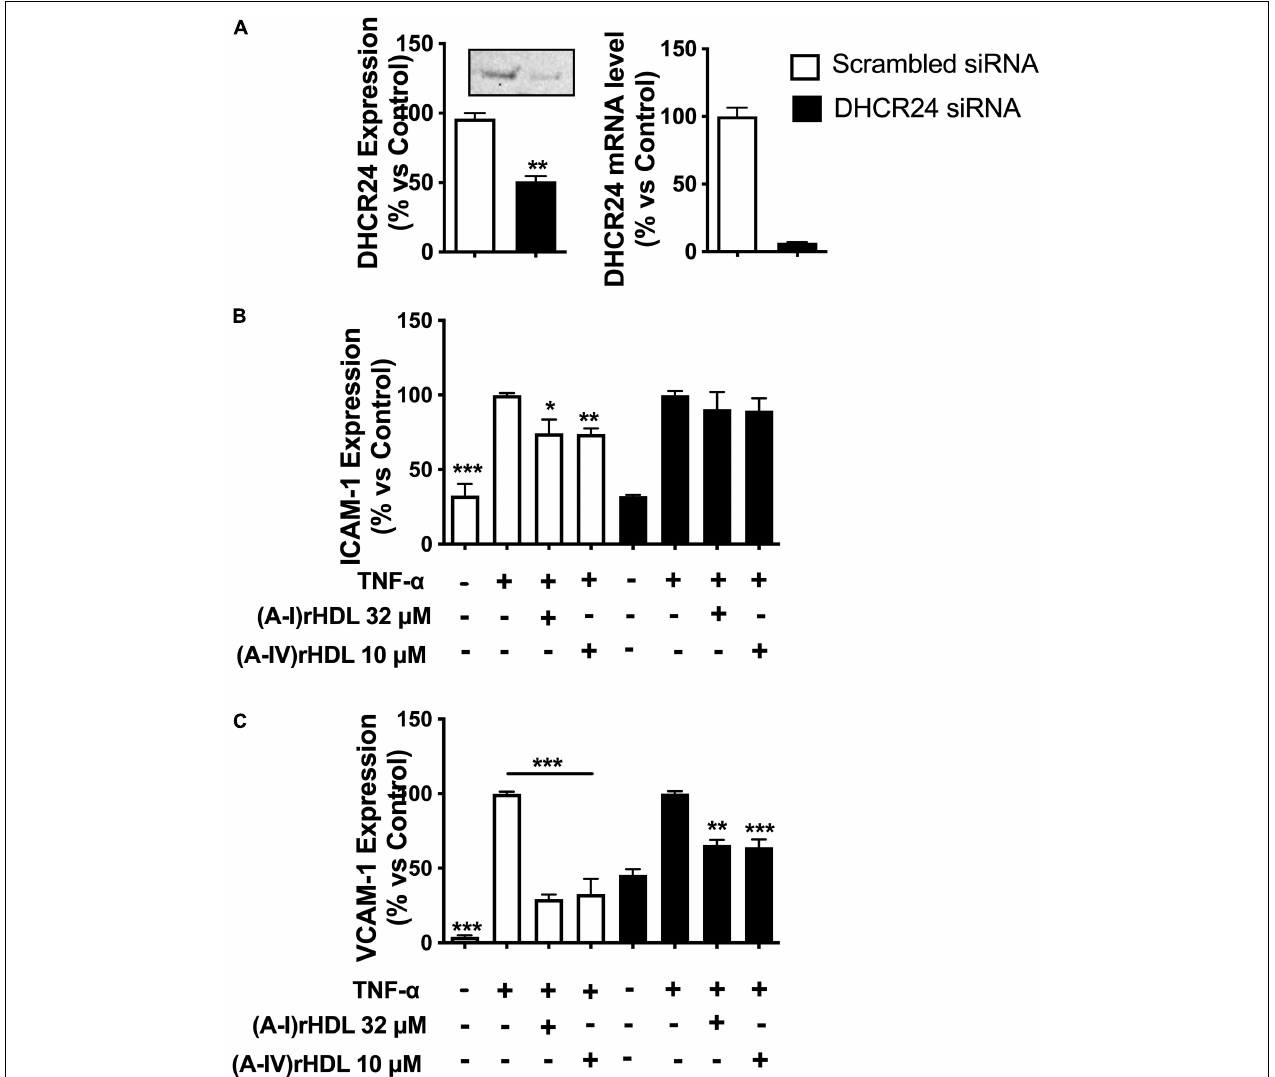
FIGURE 6 | (A-IV)rHDLs inhibit TNF- α -induced ICAM-1 and VCAM-1 expression in HCAECs in a DHCR24-dependent manner. HCAECs were transfected with DHCR24 or scrambled siRNA then pre-incubated at 37 ◦ C for 16 h with (A-I)rHDLs (final apoA-I concentration 32 µ M) or (A-IV)rHDLs (final apoA-IV concentration 10 µ M). The rHDLs were removed and the cells were stimulated for 5 h with TNF- α (final concentration 0.2 ng/mL). The reduction in DHCR24 protein and mRNA levels in the transfected HCAECs was quantified by Western blotting and qPCR [Panel (A) ]. ICAM-1 [Panel (B) ] and VCAM-1 [Panel (C) ] protein levels were